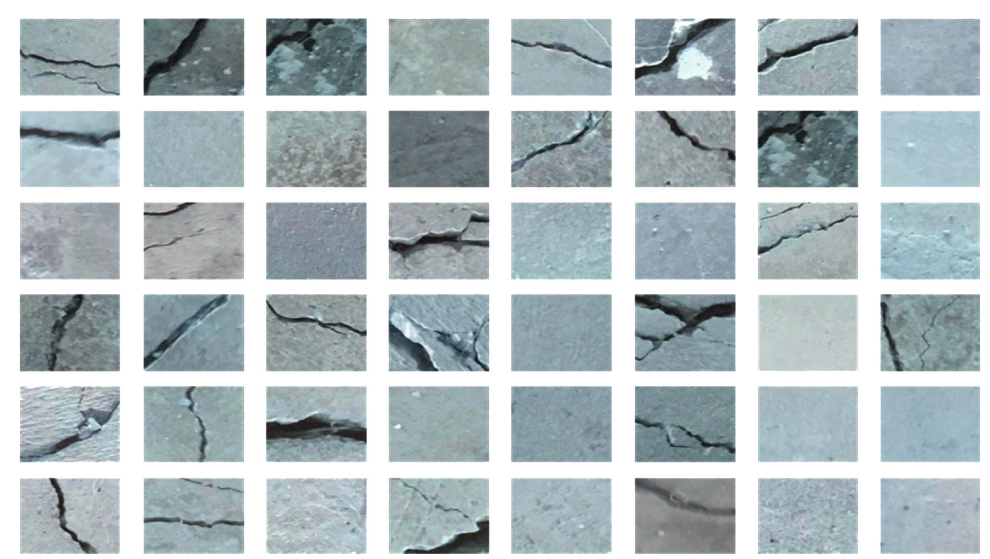
Figure 4: Image dataset